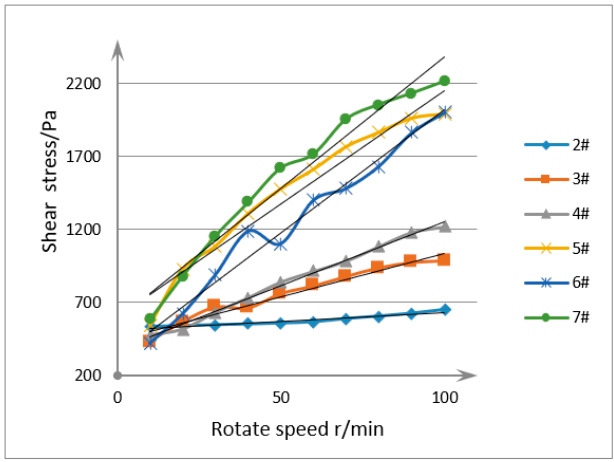
Figure 10. The initial flow properties (shear stress-shear rate variation) of the samples.